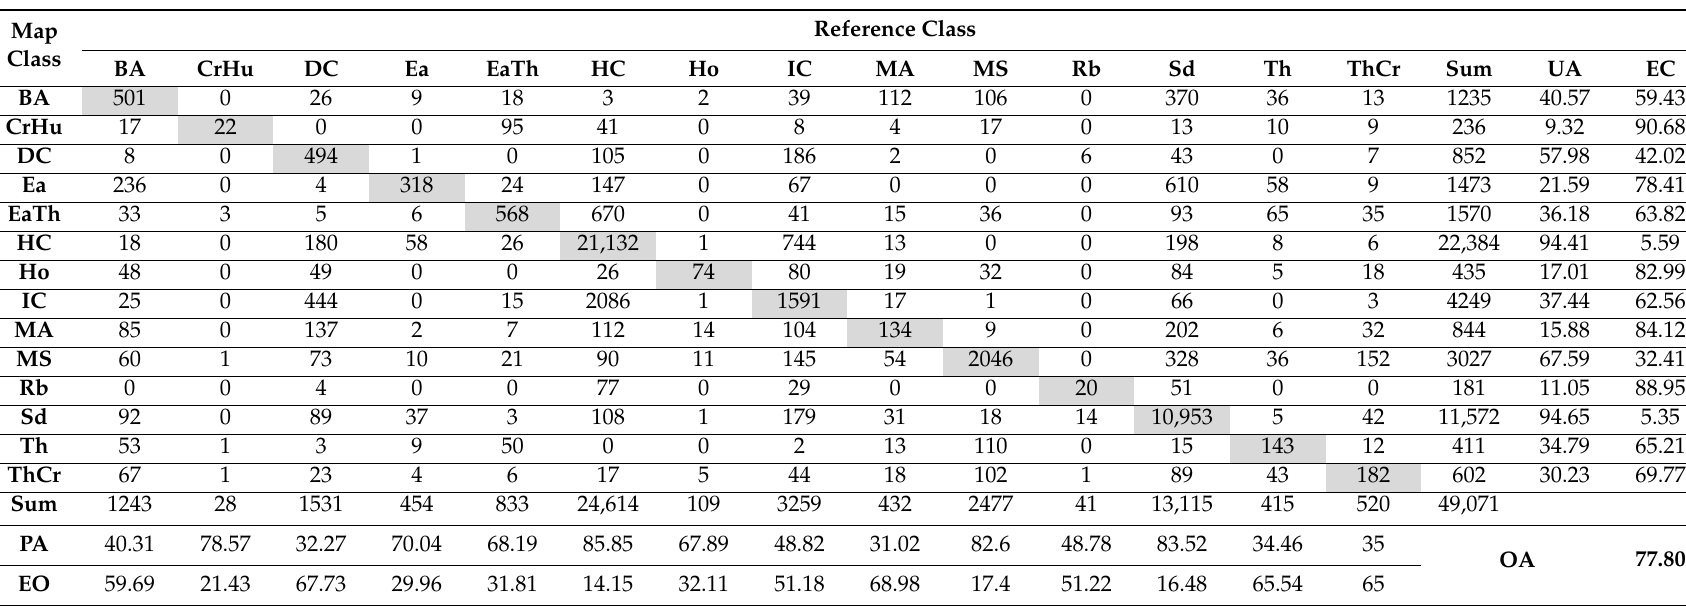
Table 5. Confusion matrix of CTA result. HC: Healthy Coral, IC: Intermediate Coral, DC: Dead Coral, BA: Brown Algae, MA: Mixed-Algae, MS: Mixed-Seagrass, Rb: Rubble, Sd: Sand. OA: Overall Accuracy, UA: User Accuracy, PA: Producer Accuracy, EC: Error Commission, EO: Error